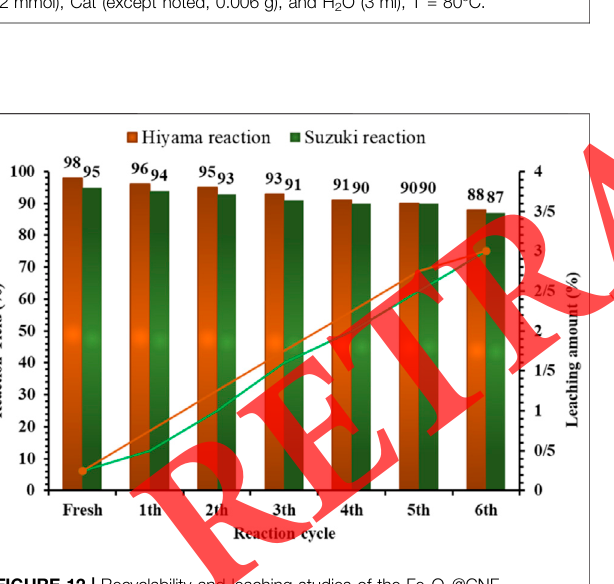
FIGURE 12 | Recyclability and leaching studies of the Fe 3 O 4 @CNF ∼ ImSBL ∼ Co. nanocatalyst.